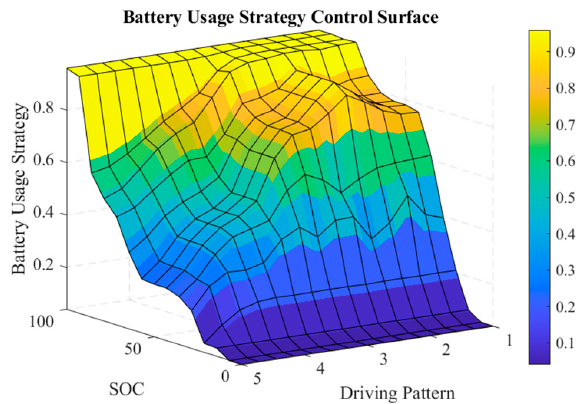
Figure 7. Control surface of our battery usage strategy.